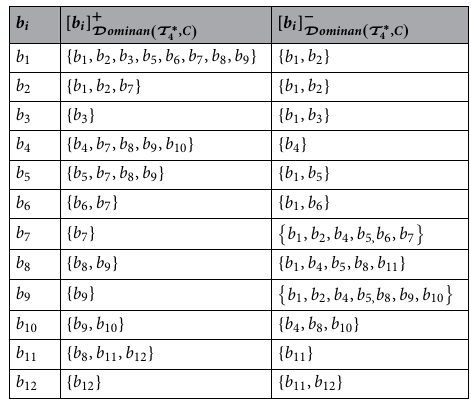
[ b i ] − D ominan ( T ∗ C ) . 4 ,